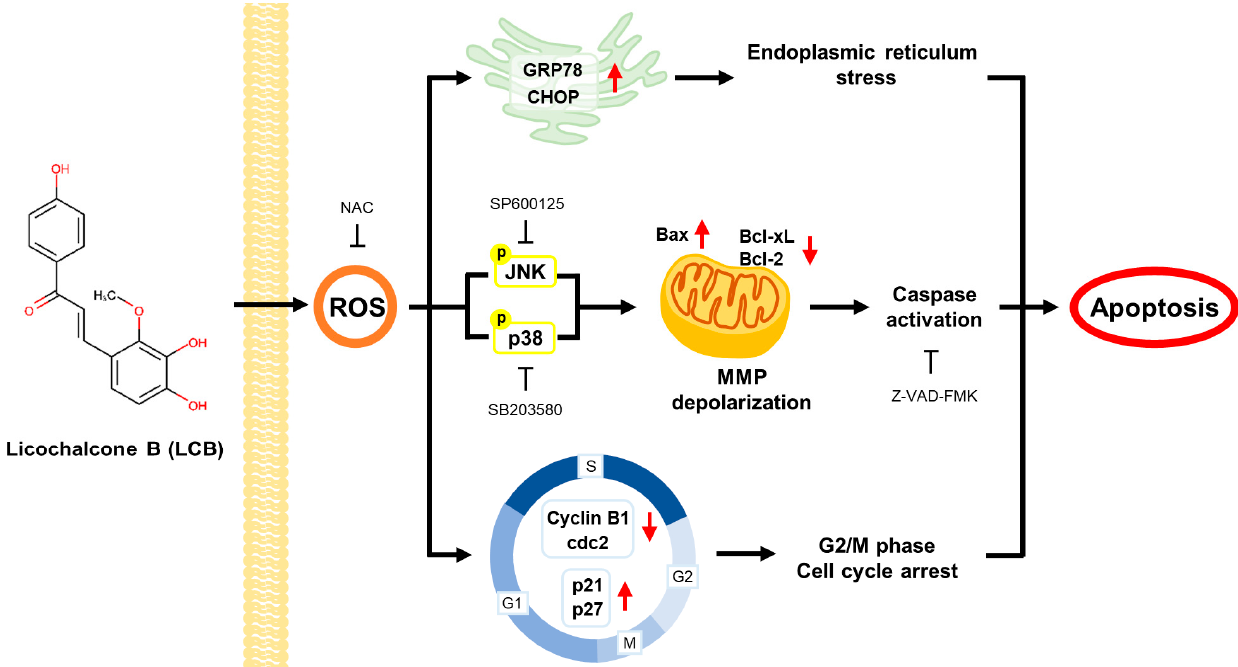
Figure 7. Schematic representation of LCB effects on Ox-sensitive and -resistant CRC cells.